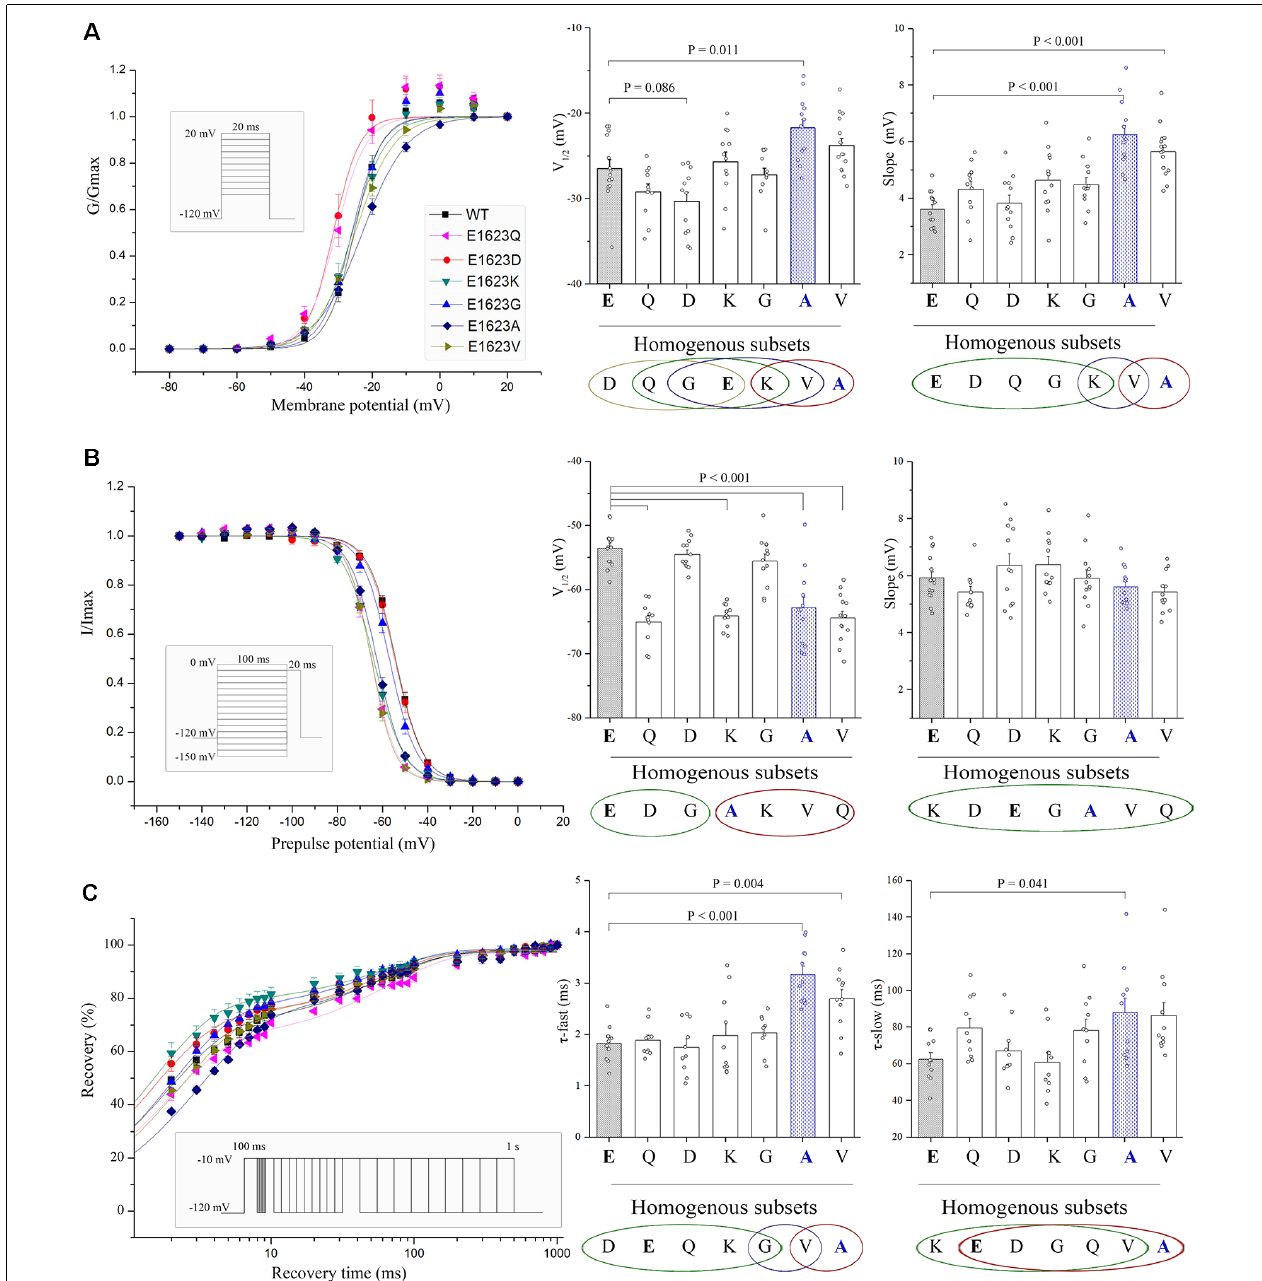
FIGURE 5 | Voltage dependence and recovery kinetics of the E1623 mutants. (A) Activation curves of all E1623 mutants. (B) Steady-state inactivation curves. For testing voltage dependent channel availability in fast inactivation, a two-pulse protocol was used. Na + currents were evoked by a 20-ms test pulse to − 10 mV after 100-ms conditioning prepulses between − 150 and 0 mV in 10-mV increments. Peak currents evoked by test pulses were measured, normalized, and plotted against the conditioning prepulse potentials. Parameters of activation and fast inactivation were estimated by fitting current-voltage relationships with the Boltzmann function. Estimated parameters including half-activation potential (V 1/2 ) and slope factor, were derived from the Boltzmann fits. Group data of the V 1/2 and slope are shown at the right panels. (C) Recovery from fast inactivation in paired stimulus experiments. Paired stimuli were applied at various inter-stimulation intervals. The recovery fractions were plotted to the intervals. The normalized recovery plots were fit with a double-exponential function to obtain parameters of τ -fast and τ -slow (shown in right panels). Statistical outputs of homogenous subsets (shown below the plots; those within the same circle are α > 0.05) indicate significant differences among the